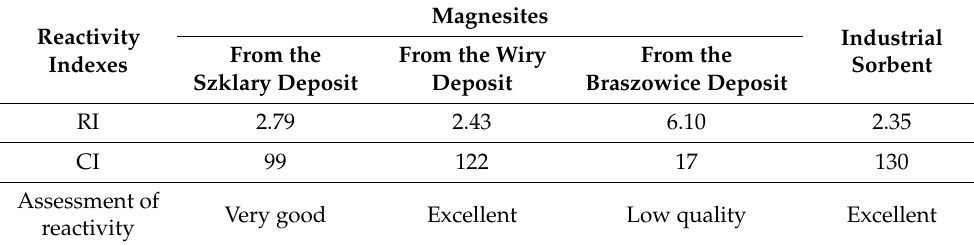
Table 5. Values of the absolute sorption (CI) [gS/1kg sorbent] and reactivity (RI) [kmol Ca/kmol S]